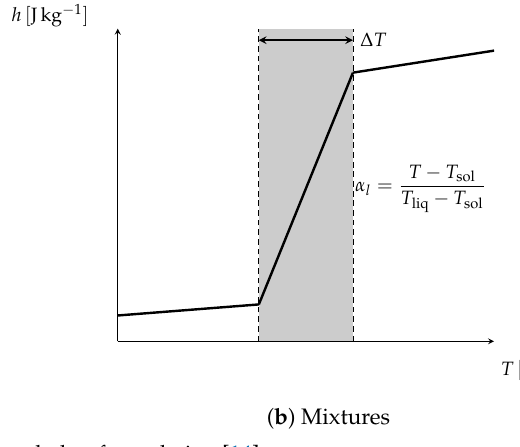
Figure 1. Examples of the enthalpy formulation